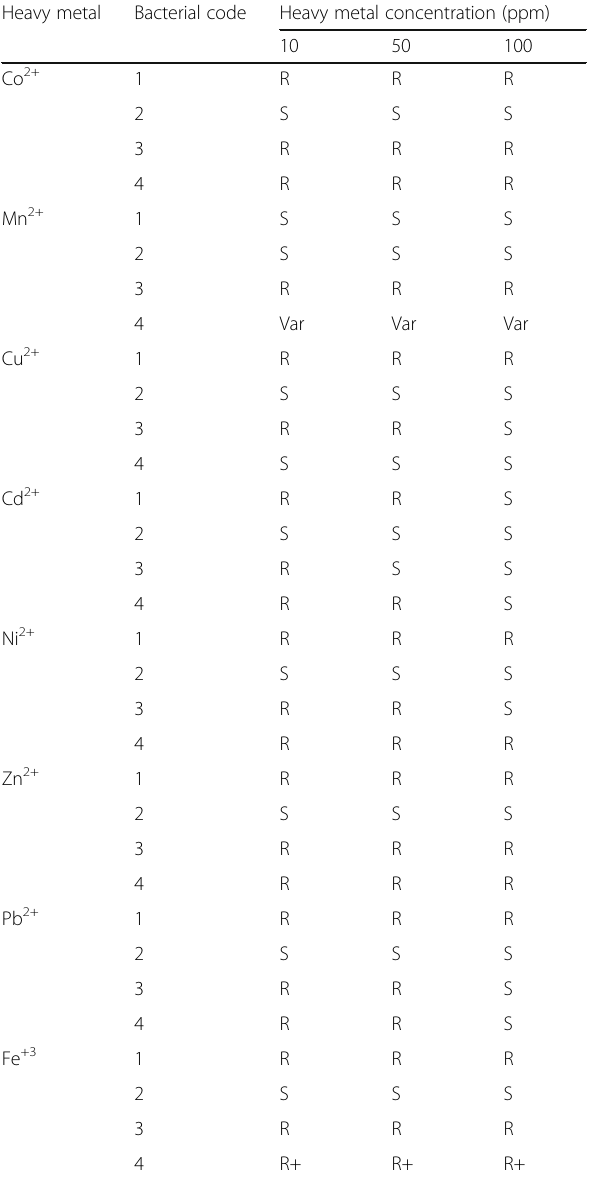
Table 1 Screening for a potent heavy metal removal bacterium able to resist different metal concentrations, expressed in parts per million Heavy metal Bacterial